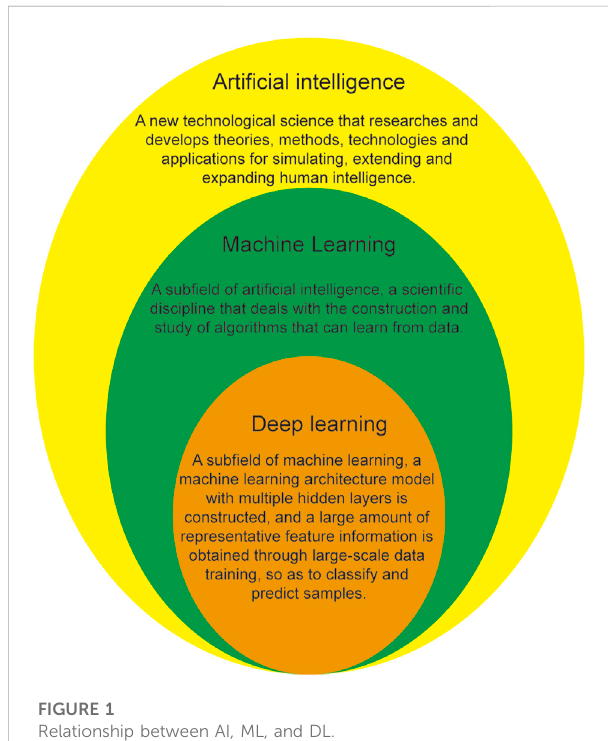
FIGURE 1 Relationship between AI, ML, and DL.